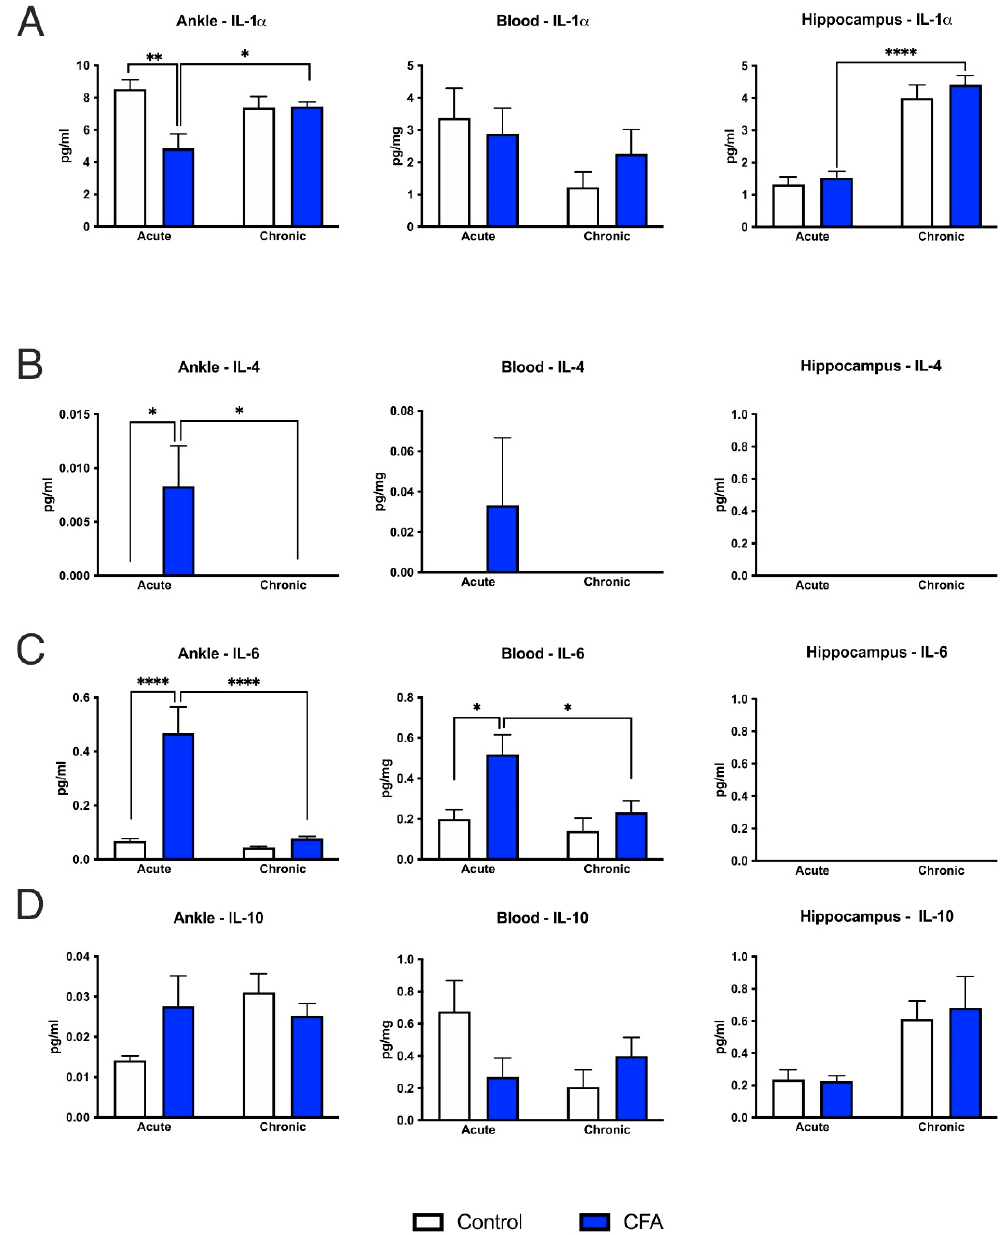
Figure 9. Cytokine/chemokine concentrations in the CFA-treated hind paws, peripheral blood and hippocampus. ( A – C ) In the hind paws, acute inflammation increased IL-4 and IL-6 concentrations and decreased IL-1 α levels. ( C ) In the peripheral blood, only IL-6 levels increased in response to acute inflammation. In the hippocampus, CFA treatment did not alter any cytokine levels compared to the corresponding control groups. ( D ) IL-10 concentrations were not altered in any tissue by the CFA-treatment. On some graphs, there are no bars, which means that those cytokine concentrations were below the detection levels. Statistics: two-way ANOVA (CFA treatment × time) followed by Tukey’s multiple comparisons post hoc test. * p < 0.05; ** p < 0.01; **** p < 0.0001. Abbreviations: complete Freund’s adjuvant (CFA); interleukin-1-alpha (IL-1 α ); interleukin-4 (IL-4); interleukin-6 (IL-6); interleukin-10 (IL-10).